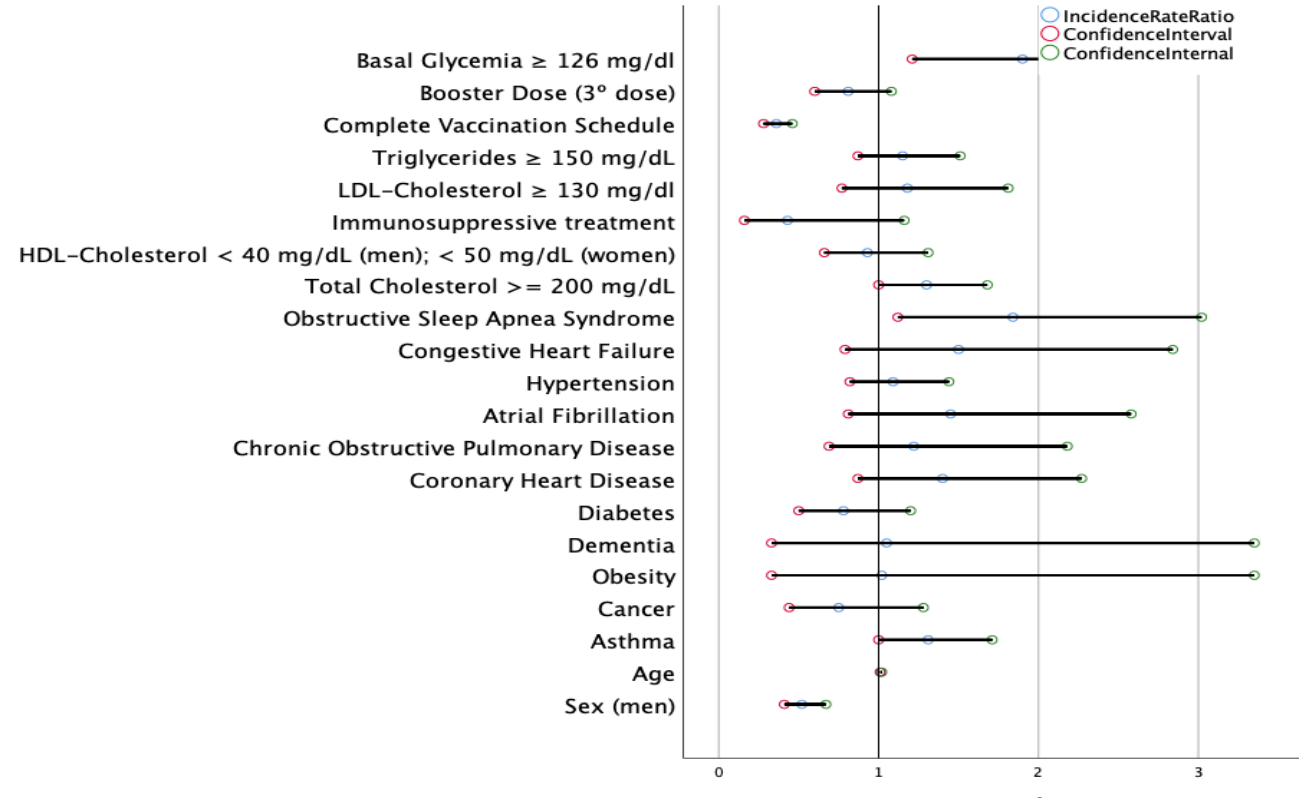
Figure 1. A multivariate Poisson regression model to explore the association between post-acute COVID-19 according to sex, age, comorbidities, laboratory test results, immunosuppressive treatment and vaccination schedule in 110,726 SARS-CoV-2-positive patients admitted to hospital. A multivariate Poisson regression model was used. p values of the variables of interest according to a